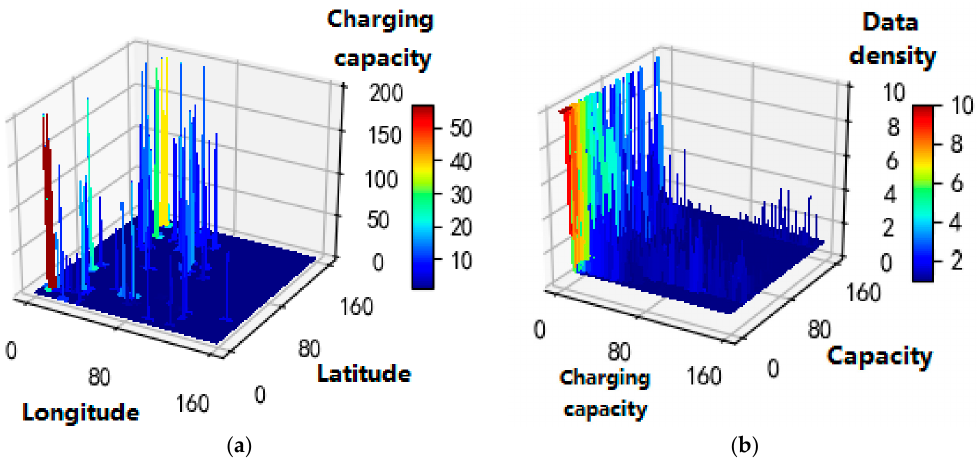
Figure 5. Relationship between charging data distribution and charging station character: ( a ) capacity and location; and ( b ) data density and stations.